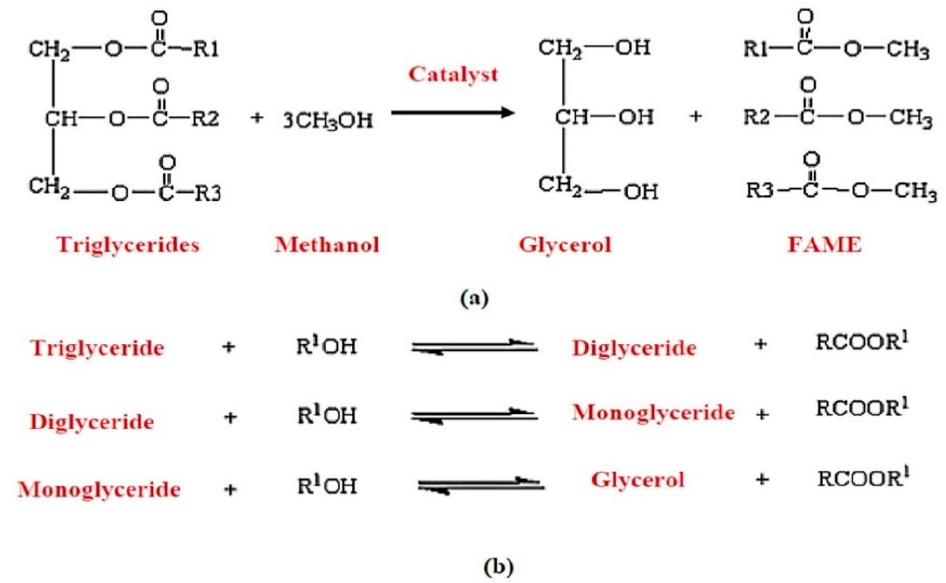
Figure 4. ( a ) A general reaction involving transesterification. ( b ) A detailed explanation of the mechanism behind the transesterification reaction.